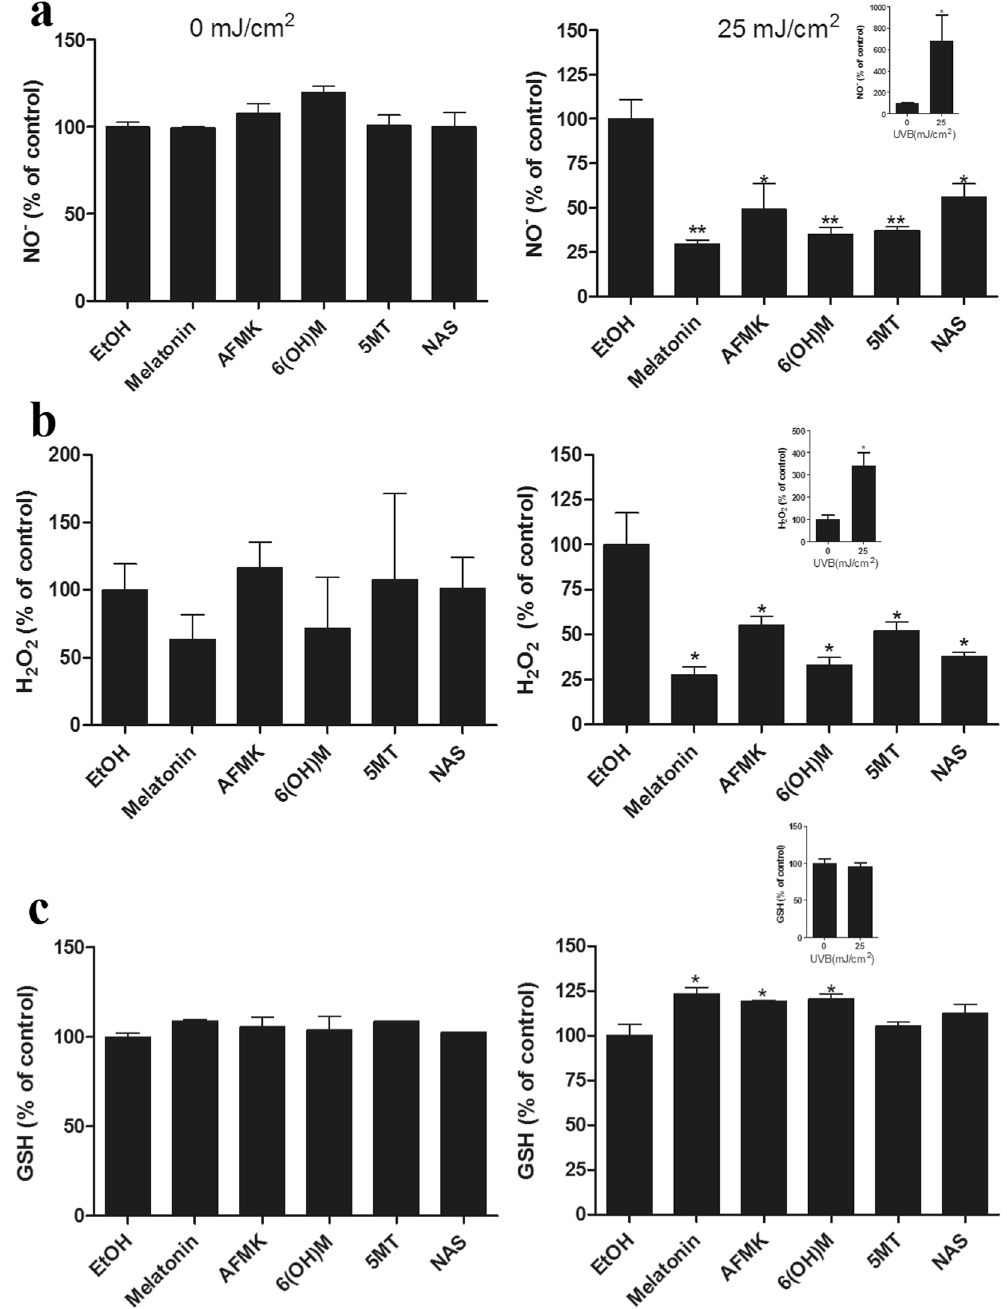
Figure 1. Melatonin, NAS, 6-OHM, AFMK, and 5-MT reduce UVB-induced oxidative stress. UVB-irradiated (25 mJ/cm 2 ) and non-irradiated melanocytes (comparison presented as inserts) were treated with melatonin or its metabolites for 24 h prior UV irradiation at the concentration 5 × 10 − 5 M. NO-( a ) or H 2 O 2 ( b ) produced in melanocytes were determined 30 min after UVB irradiation, while GSH levels ( c ) were determined 1 h post UVB. Data were analyzed using student t-test, * p < 0.05, ** p <